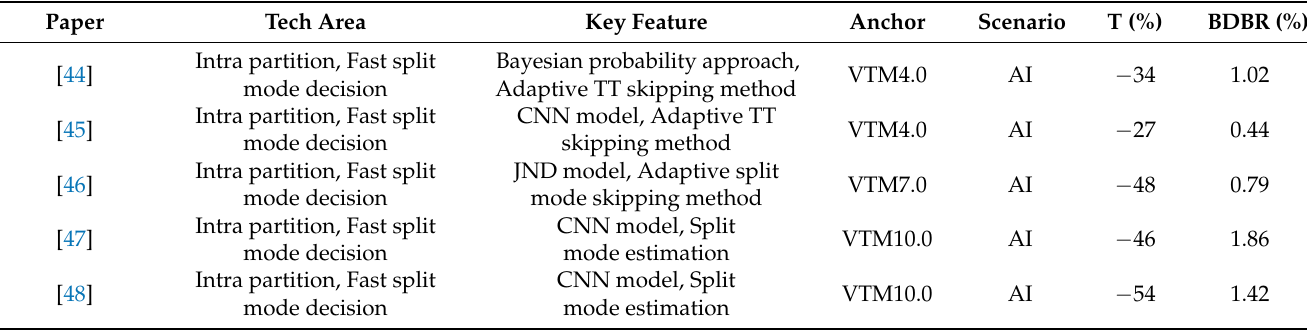
Table 1. Summary of fast methods on early split mode